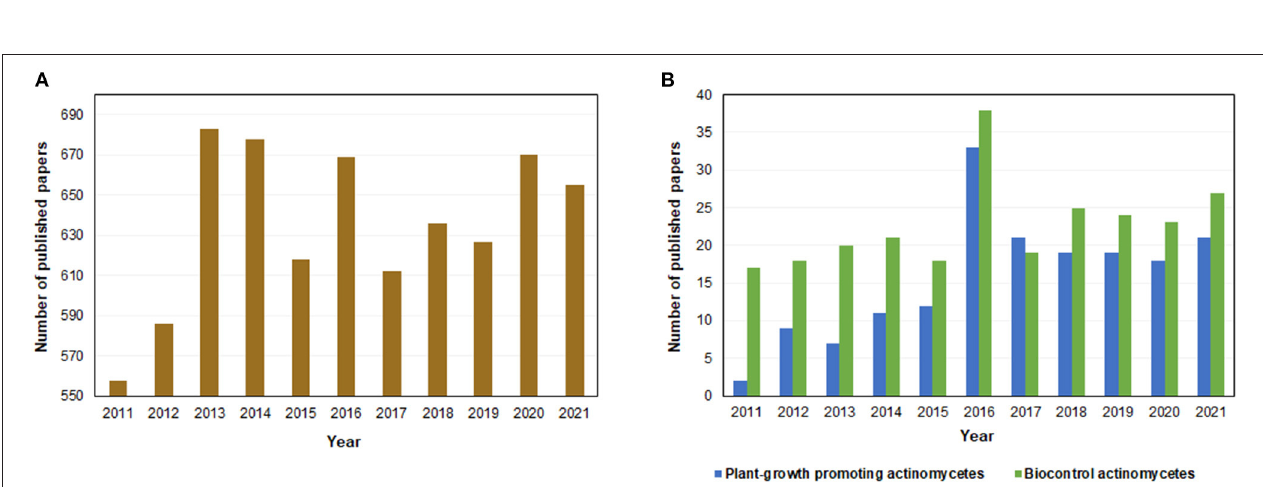
FIGURE 2 | Number of papers published in the period from 2011 to 2021 regarding (A) actinomycetes and (B) plant-growth promoting actinomycetes and biocontrol actinomycetes, found on Scopus database.